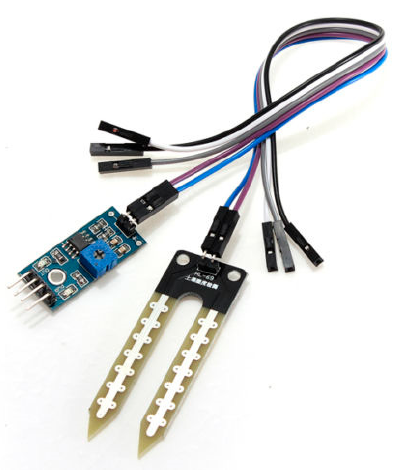
Figure 5. A HL-69 Soil Hygrometer for soil moisture sending.